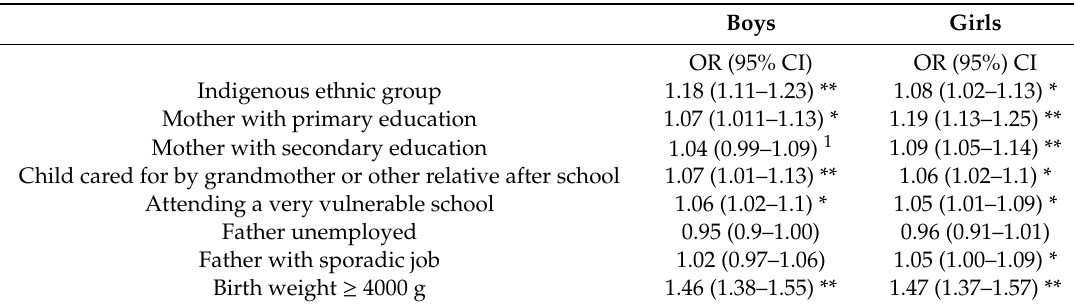
Table 4. Multivariate logistic regression model showing predictive variables associated with normal-weight prekindergarten children developing overweight or obesity by first grade, by